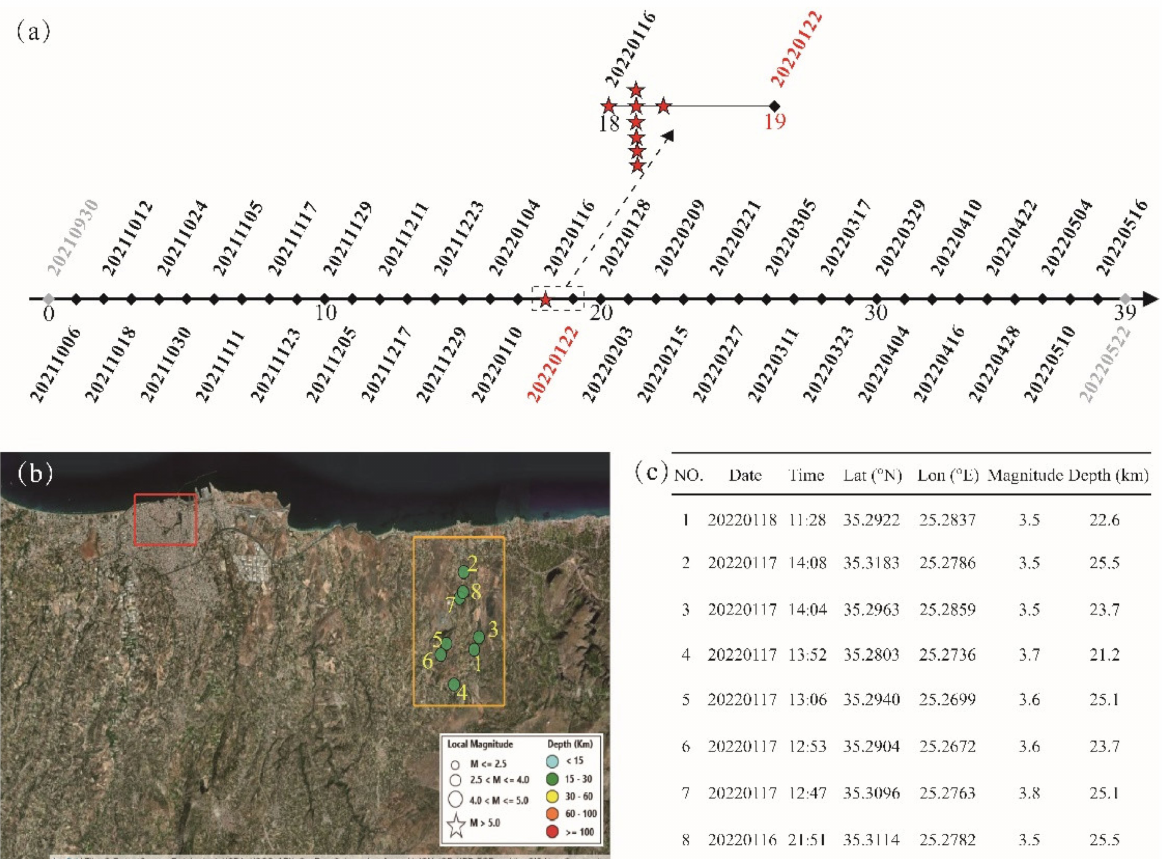
Figure 12. The timeline and each SAR acquisition date with number identifications and the earth- quake sequence on 16–18 January 2022. As described in Section 4.2.2, the first date 30 September 2021 and the last date 22 May 2022 were assumed the same as the adjacent one. ( a ) Timeline and each SAR acquisition date with number identifications, red stars represent earthquakes that happened on 16 January 2022 (1 event), 17 January 2022 (6 events on the same date) and 18 January 2022 (1 event); ( b ) locations of the 8 earthquakes with magnitudes larger than 3.5, red rectangular shows the HCW location, yellow rectangular shows where the earthquake sequence located; ( c ) detailed information of the 8